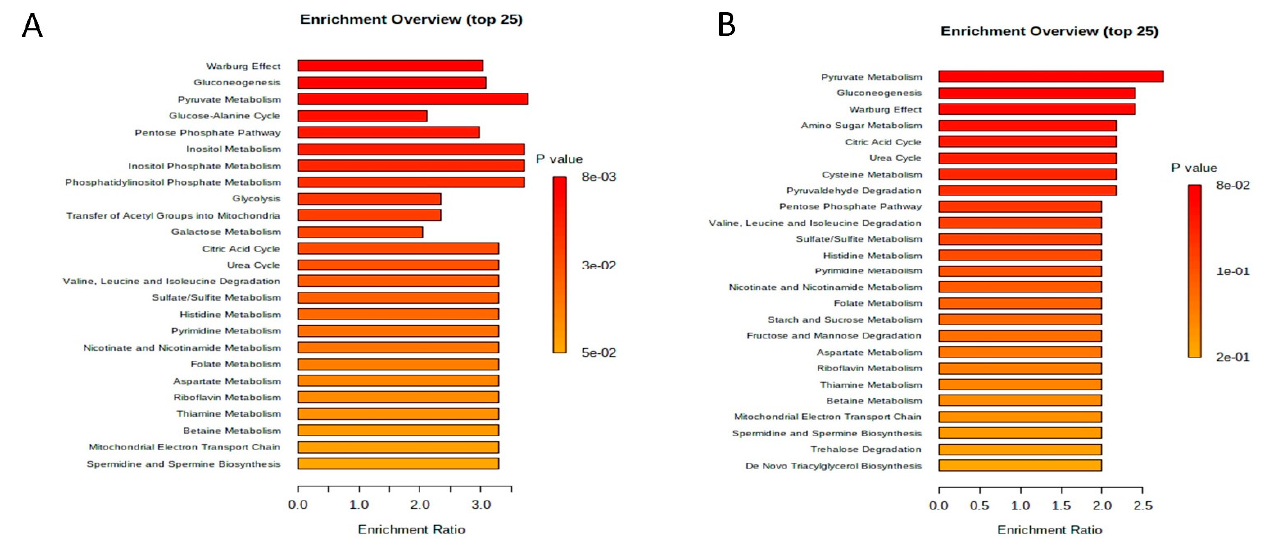
Figure 8. Metabolomic set enrichment analysis of MDA-MB-231 and MCF-7 cells. Notes: Metabolomic set enrichment analysis showing the most changed functional metabolism of MDA-MB-231 ( A ) and MCF-7 cell lines ( B ) after treatment with compound 1 in duration of 48 h. Molecular pathways were ranked according to the probability ( p -value) of finding a particular number of significantly changed metabolites in the compound list of a certain pathway.